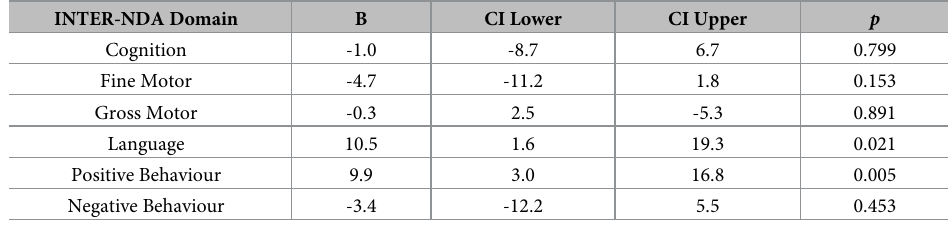
Table 2. Intervention Effects on Child Development Domains Measured by the